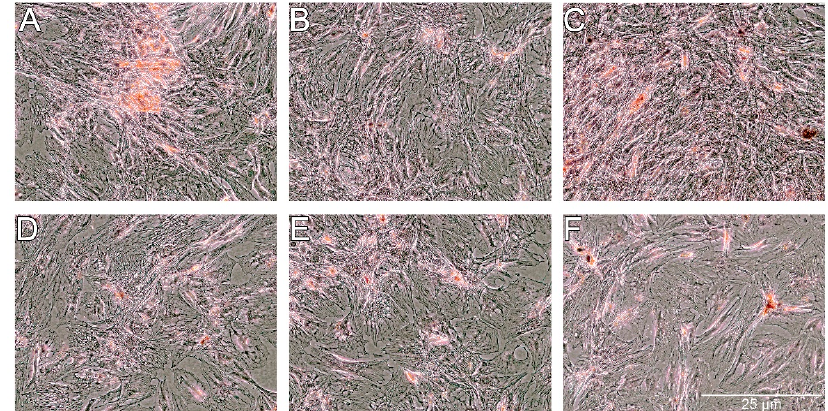
Figure 9. Alizarin Red staining of extracellular calcium after exposure of ADSC to the tested combinations of antibiotics. ADSC were exposed for 14 days to AmB ( B ), AmB-Cu 2+ ( C ), PS ( D ), PS-AmB ( E ) and PS-AmB-Cu 2+ ( F ), and compared to the control cells ( A ).